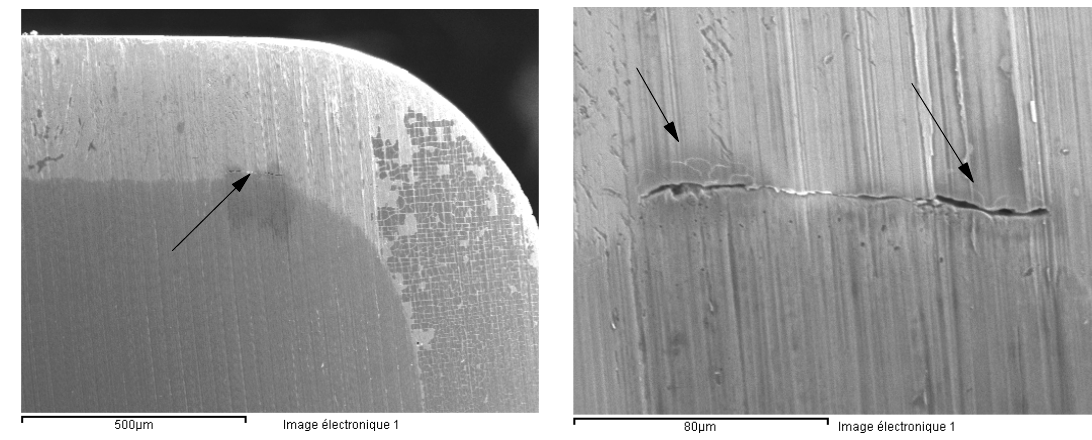
Figure 26. SEM examination of sample #4.